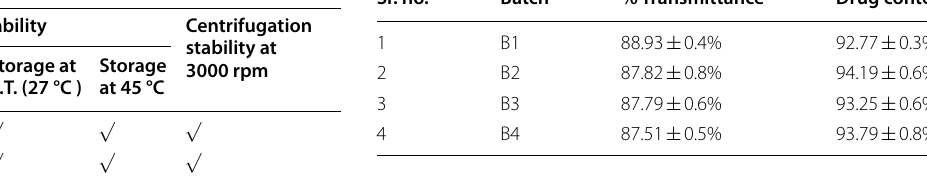
Table 2 Thermal and centrifugation stability of tenofovir nanoemulsion